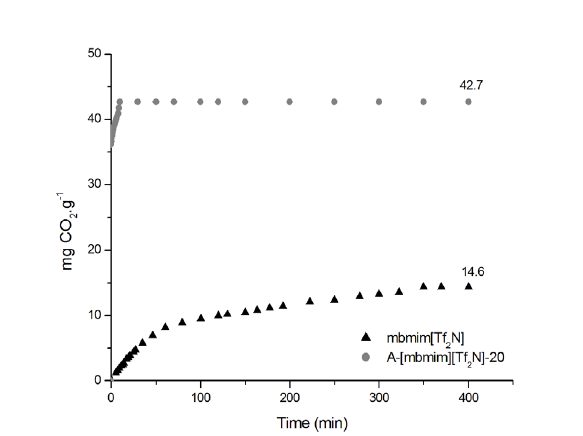
uptake in neat: (▲) mbmim[Tf 2 N]-20. 2